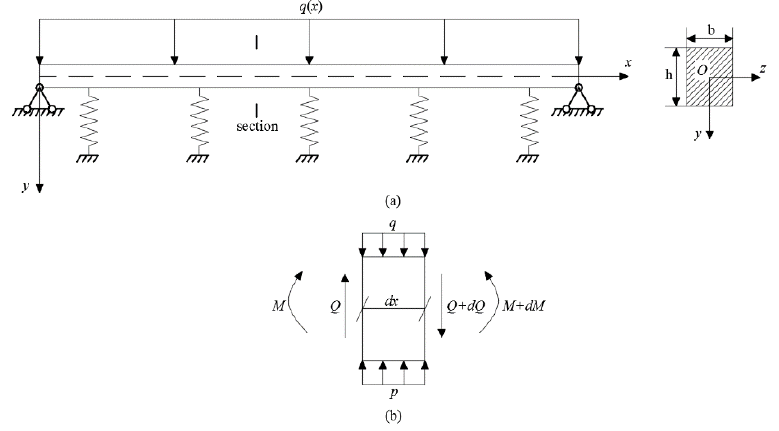
Figure 2. ( a ) Modelling the geocell layer as a beam on elastic foundation; ( b ) A geocell beam ele-